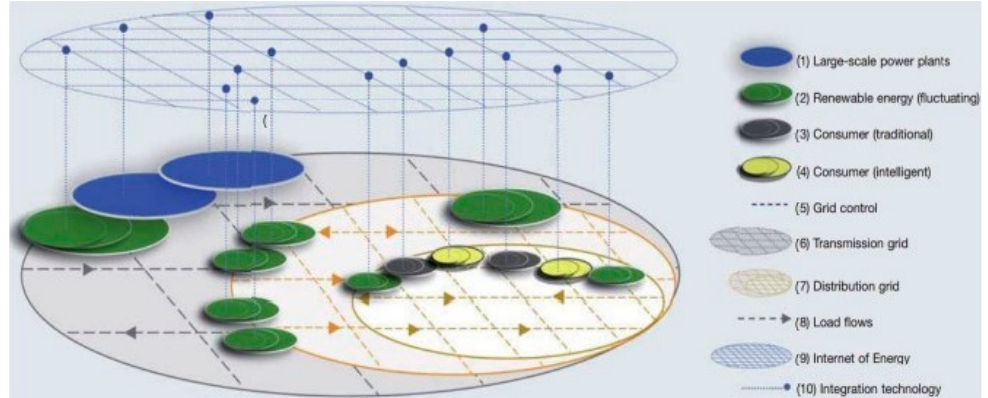
Figure 4. Application of IoE for transmission and sub-transmission of data at two levels of protec- tion [105].